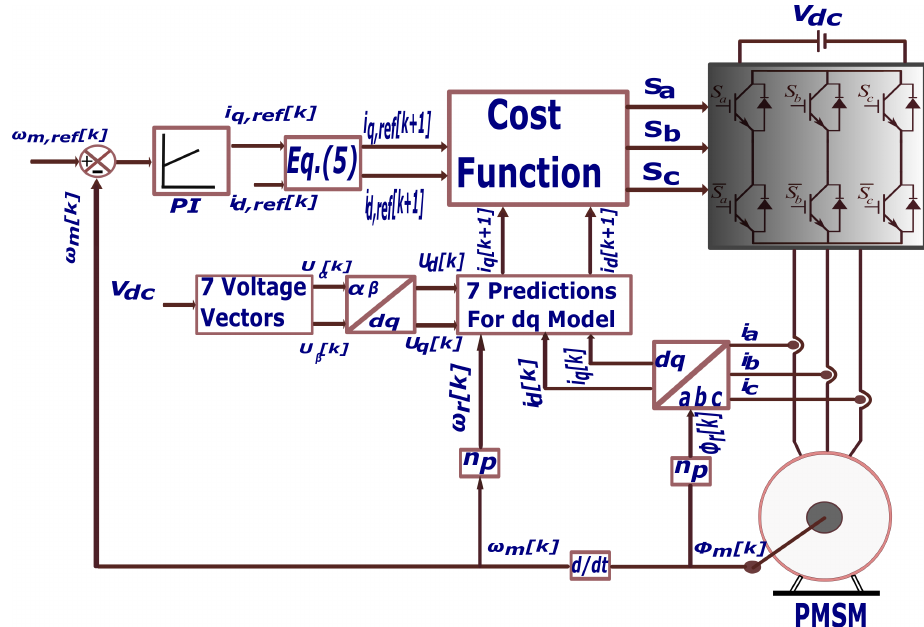
Figure 2. Conventional FCS-MPC (finite-control-set model predictive control) for a permanent- magnet synchronous motor (PMSM) drive